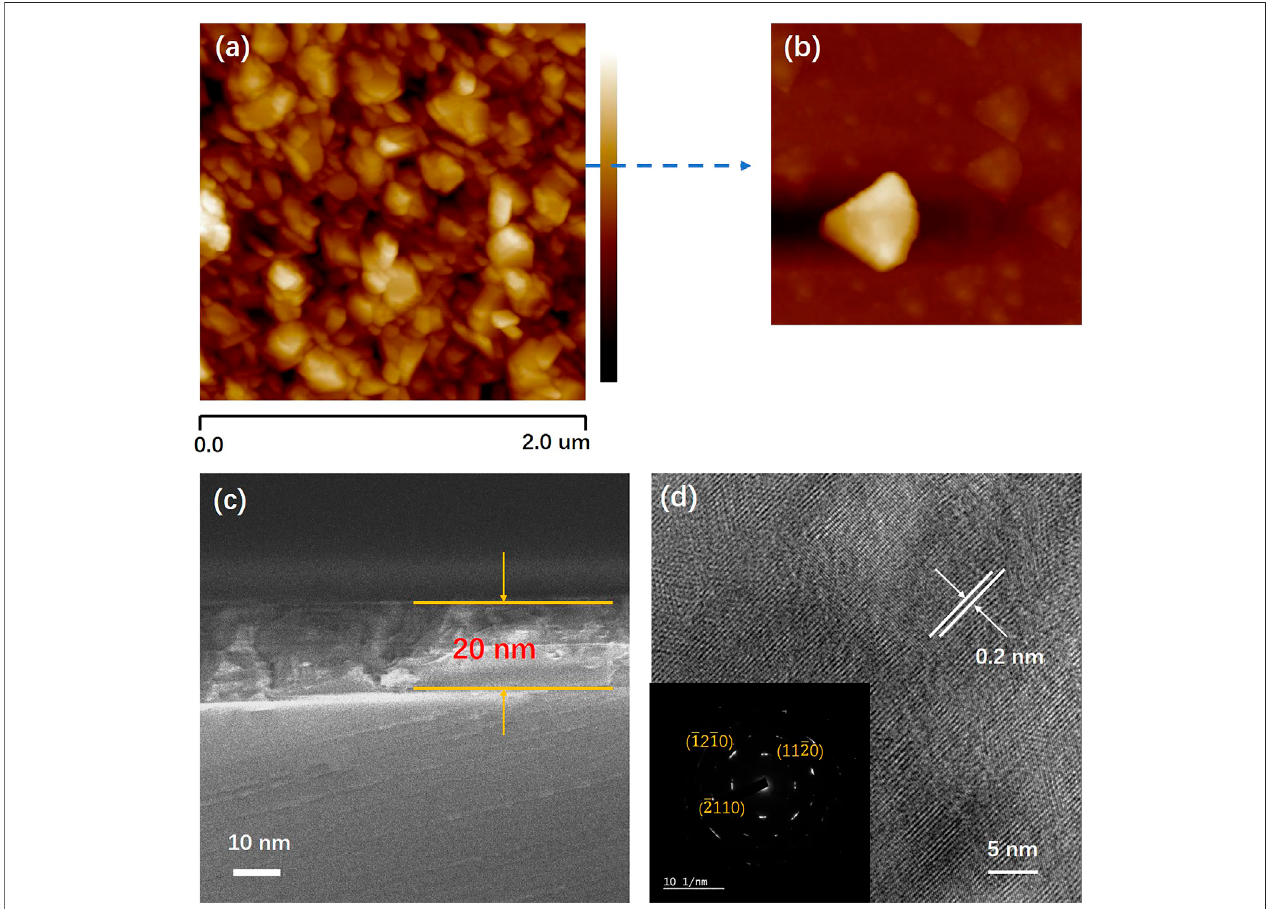
FIGURE3|(A) 2 μ m×2 μ matomic force microscopeimages oftheBi 2 Se 3 thin fi lm, (B) Enlarged image ofBi 2 Se 3 grain, (C) Cross-sectionalSEM image ofBi 2 Se 3 (001) thin fi lm close to the interface of the substrate, (D) Surface HRTEM image and SAED pattern of Bi 2 Se 3 thin fi